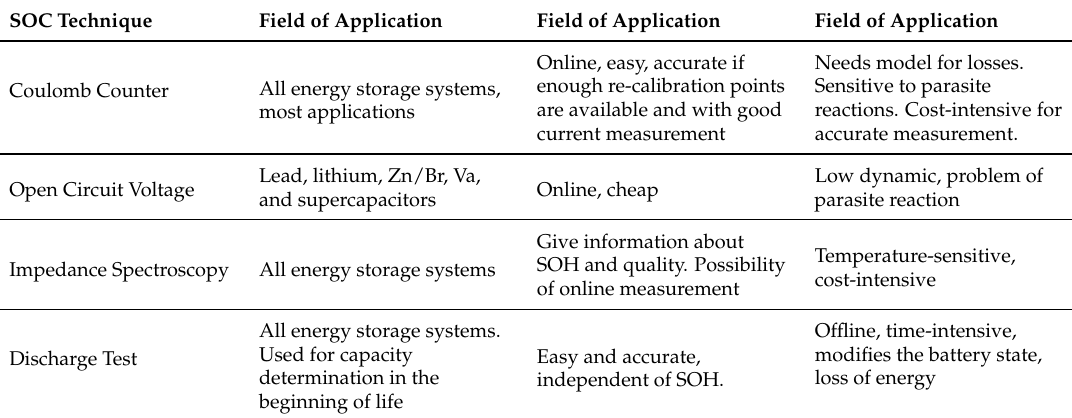
Table 4. State-of-charge (SOC) estimation methods [56,58,59]. SOH: